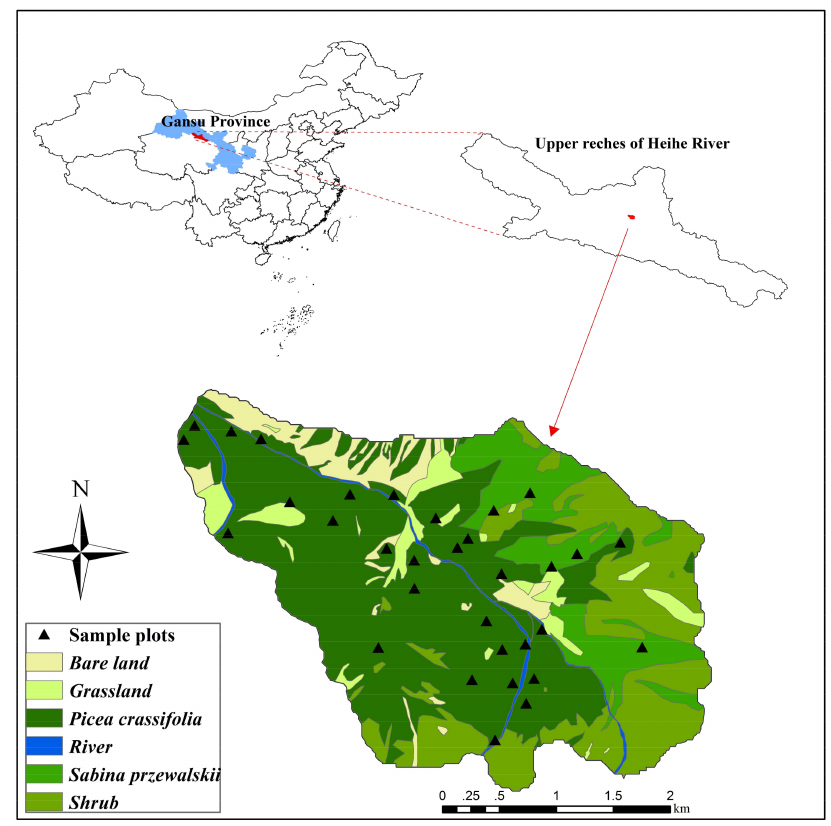
Figure 1. The spatial distribution of land use type and sample plots in our study